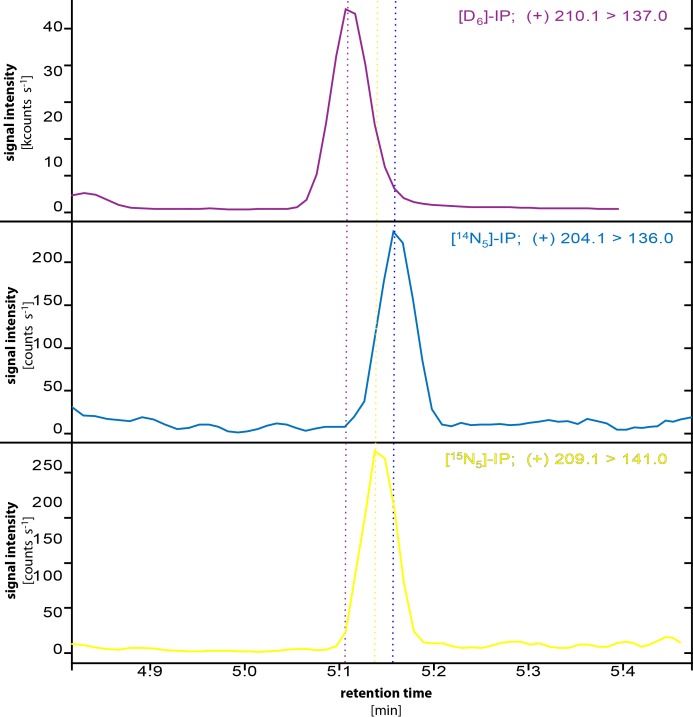
Chromatograms of IP, [D6]-IP, [15N5]-IP.Dashed lines show the retention-time shifts between unlabeled [14N5]-IP, [D6]-IP (internal standard) and [15N5]-IP. Color coding follows that of the chromatograms. The monitored parental → daughter ion transitions are given in the top right of each chromatogram.